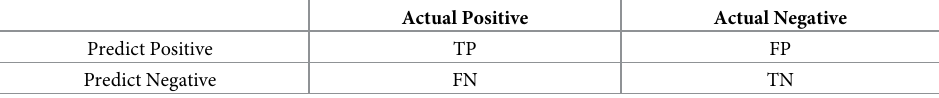
Table 1. Confusion matrix. TP denotes the number of prediction objects that are real rebars, FP denotes the number of prediction objects that are not real rebars, and FN denotes the number of real rebars that are not